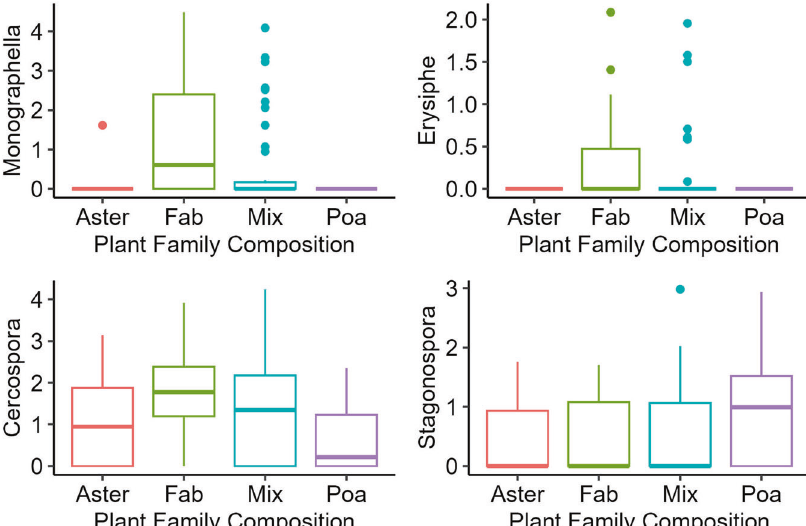
Fig. 5 Differential relative abundance of fungal pathogen OTUs in response to plant family composition treatment. Fungal genera in soil with pathogens that respond signi fi cantly to the plant family treatment, “ Mix ” indicates over-dispersed treatments with more than one plant family, while “ Aster ” , “ Fab ” , and “ Poa ” indicate under-dispersed plots with only Asteraceae, Fabaceae, or Poaceae, respectively. Fungal genera on y axis are log-transformed relative abundance calculated from OTU counts. See Supplementary Appendix Table 3 for anova